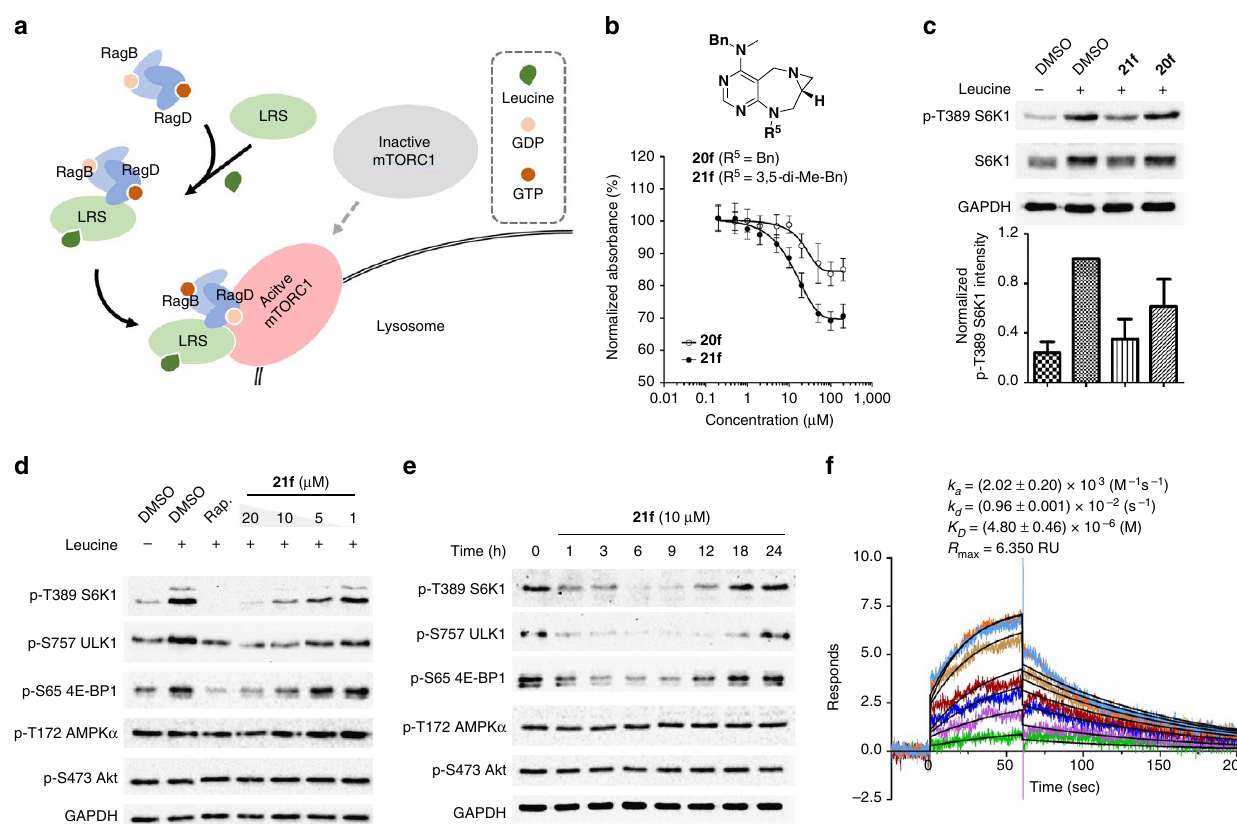
Figure 5 | Discovery of chemical modulator for LRS–RagD interaction. ( a ) Noncanonical role of LRS. Leucine-loaded LRS binds to RagD, which promotes the translocation of mTORC1 to lysosomal surface and subsequent activation. ( b ) Dose–response curves in ELISA of 20f and 21f . The results represent the mean of three biological replicates; error bars represent the s.e.m. ( c ) Effects of 20f and 21f on mTORC1 signalling pathway. HEK293Tcells were treated with 20 m M of 20f and 21f for 3h. As a negative control, cells were deprived of leucine for 3h. Level of phospho-T389 S6K1 were quantified against a DMSO control. The bar graph represents the mean of five biological replicates; error bars represent the s.e.m. ( d ) Dose-dependent effects of 21f to mTORC1 signalling pathway. HEK293Tcells were treated with 20, 10, 5 and 1 m M of 21f for 3h. As a negative control, cells were deprived of leucine for 3h. Rapamycin (Rap) was used as a positive control and cells were treated with 200nM of Rap for 3h. ( e ) Time-course study of the inhibitory effect of 21f on mTORC1 signalling pathway for 0–24h. HEK293T cells were treated with 10 m M of 21f . Phospho-T389 S6K1, phospho-S757 ULK1, phospho-S65 4E-BP1, phospho-T172 AMPK a , phospho-S473 Akt, S6K1 and GAPDH were determined by western blot. The western blot results shown are representative of three biological replicates. ( f ) Sensorgrams of SPR spectroscopy of 21f showed its concentration-dependent binding to purified LRS. The concentration plotted are 1, 2.5, 5, 10, 12.5, 15, 17.5 and 20 m M, in order of increasing 21f . The curve fittings are shown in black. The sensorgrams represent the mean of two biological replicates. The full gel images of western blotting are in Supplementary Fig. 22.